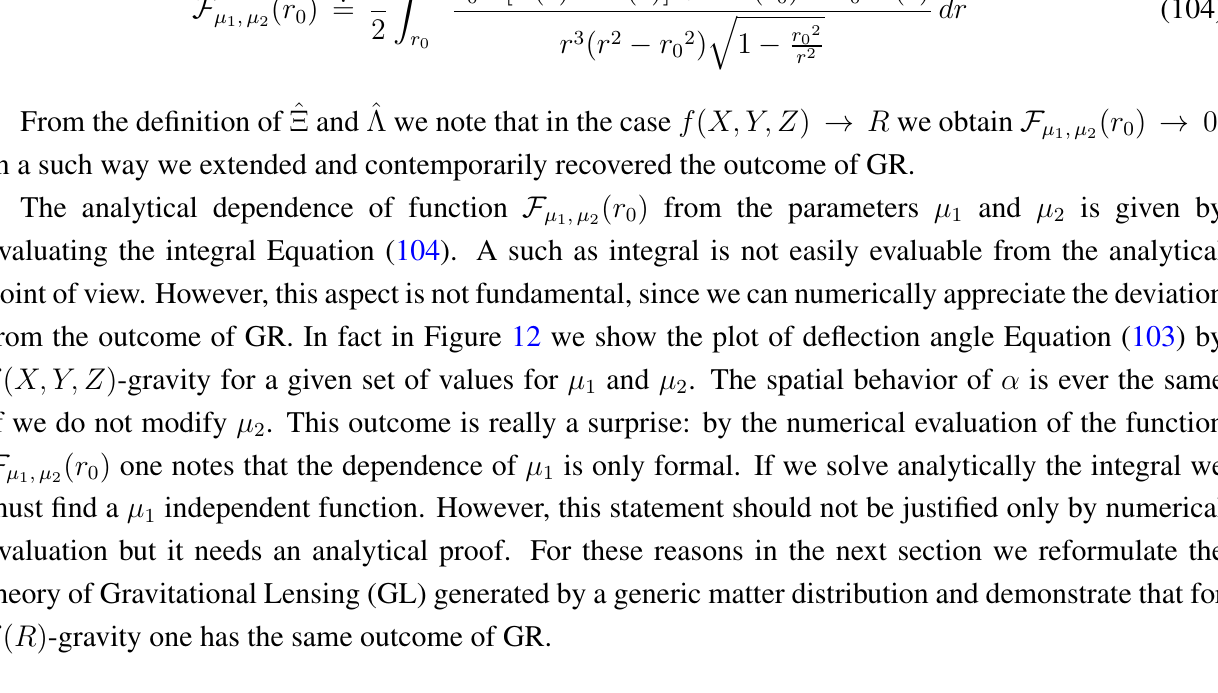
Comparison between the deflection angle of GR (solid line) and one of f ( X, Y, Z ) -gravity (dashed line) Equation (103) for a fixed value µ